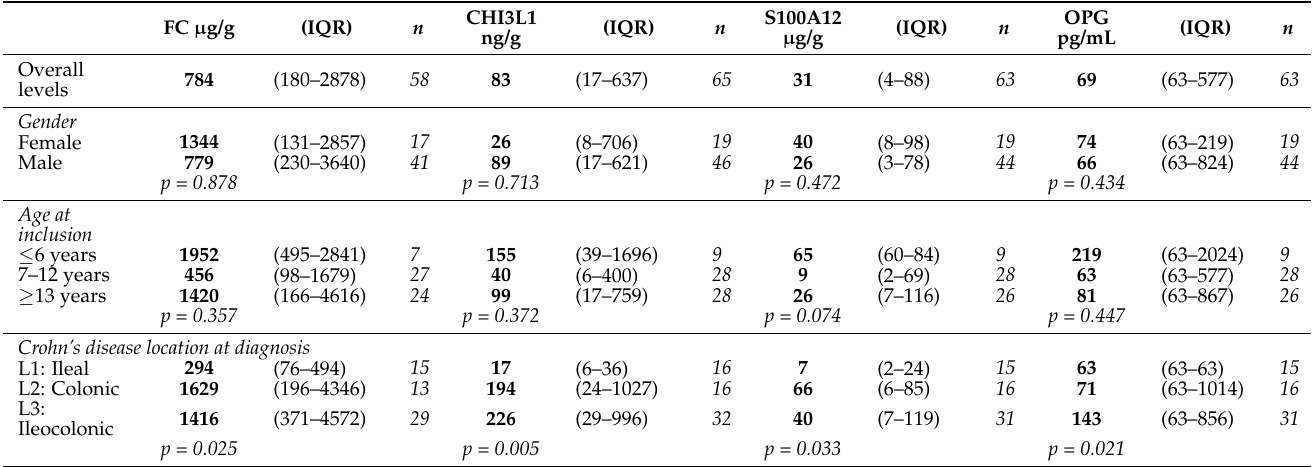
Table 2. Levels of fecal biomarkers in children with Crohn’s